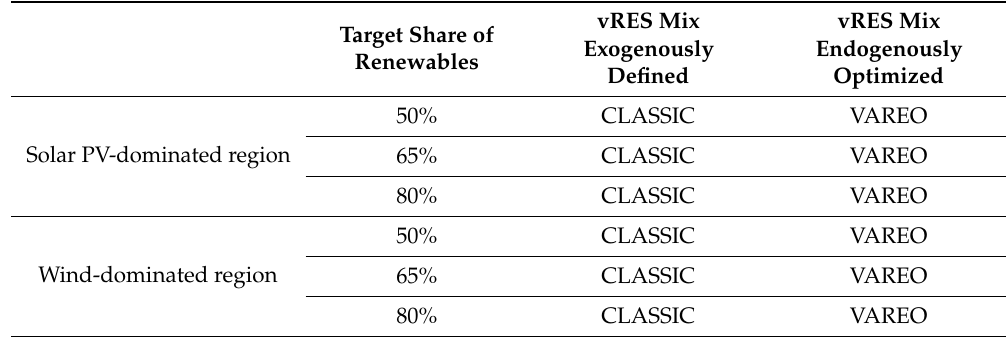
Table 1. Overview of all 12 scenarios.